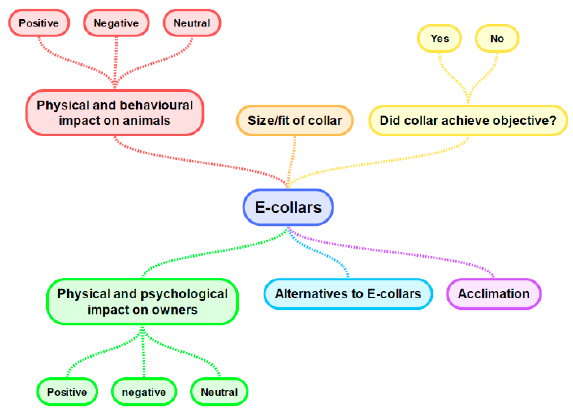
Figure 5. Map of key themes identified via thematic analysis of “additional comments”.